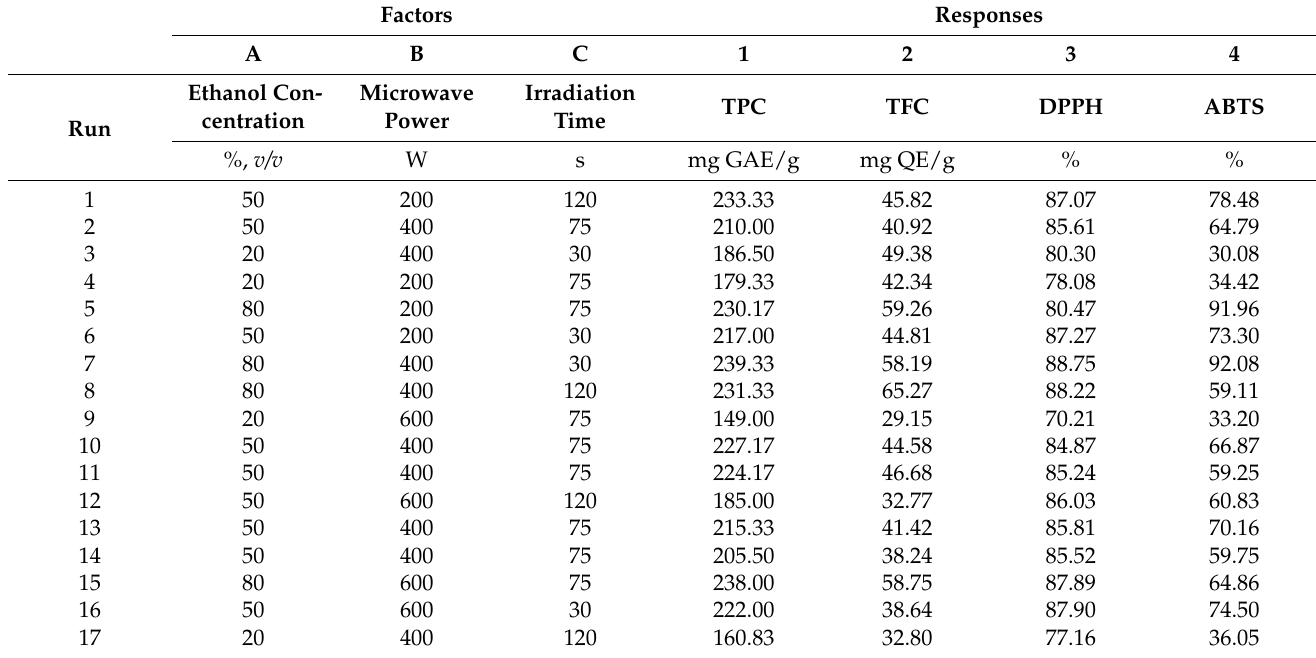
Table 6. Box–Behnken design with responses of variables.